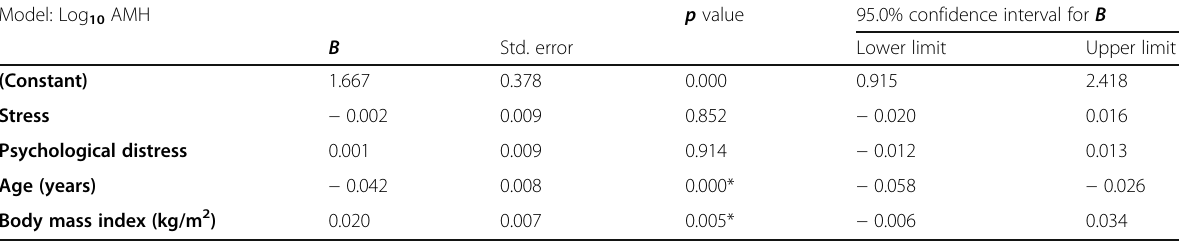
Table 3 Multivariate linear regression among infertile women Model: Log 10 AMH